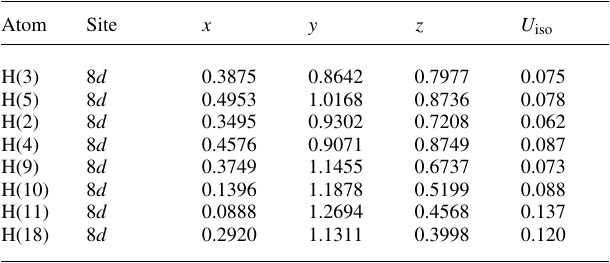
Table 2. Atomic coordinates and displacement parameters (in Å 2 )